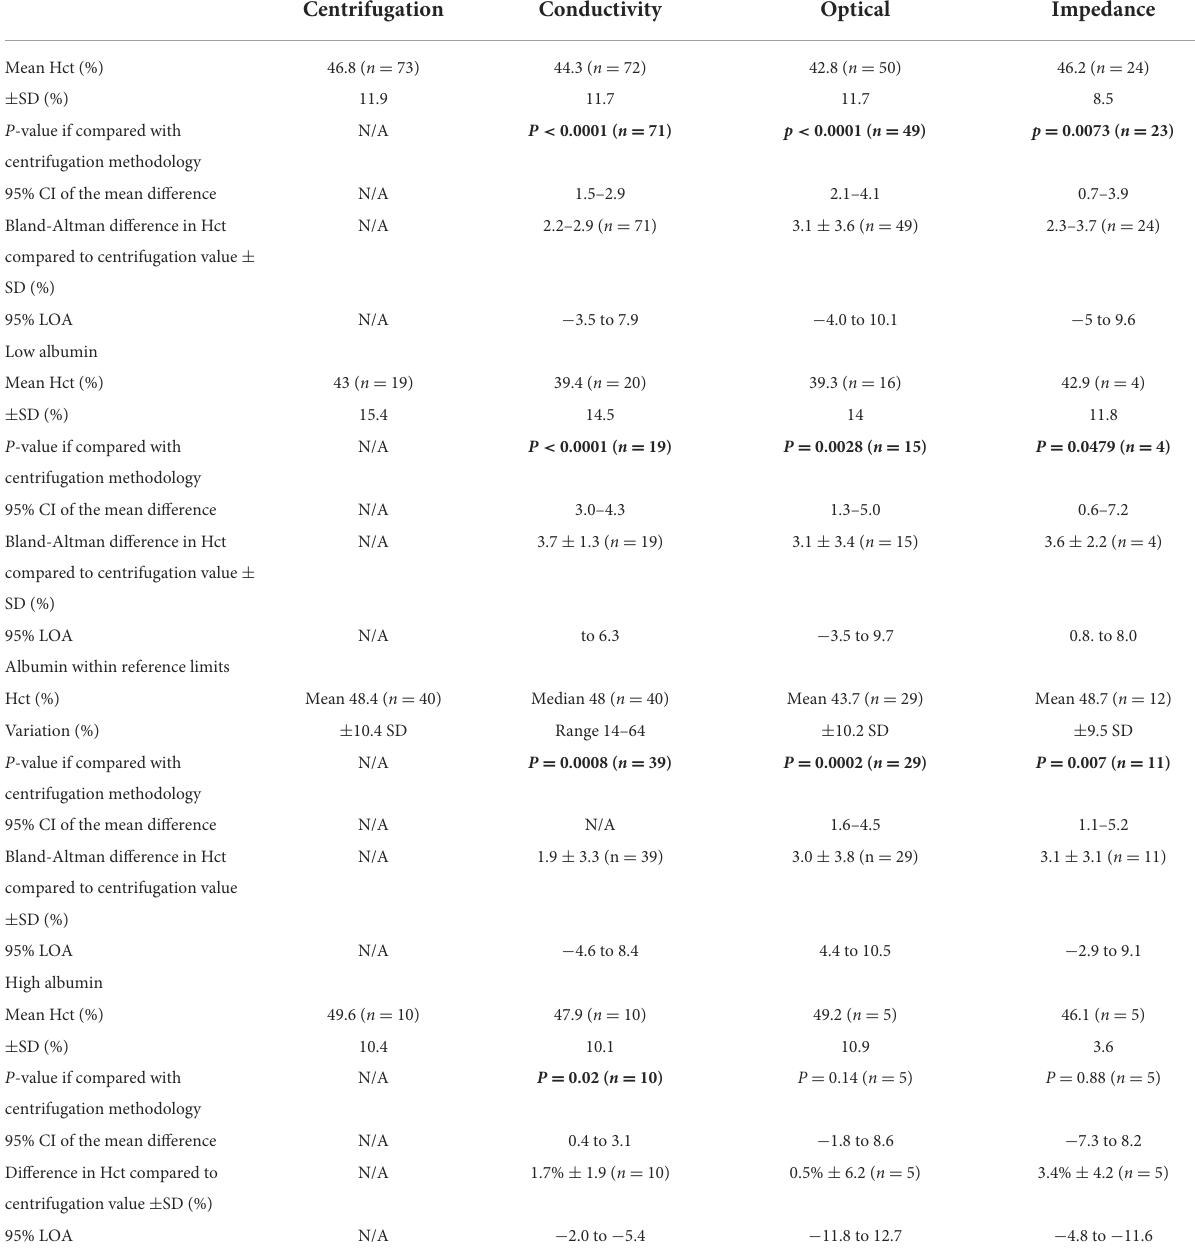
TABLE 1 Hct values and Bland-Altman difference with 95% LOA for three methodologies and for cases with low, within reference limit, and high albumin levels compared to